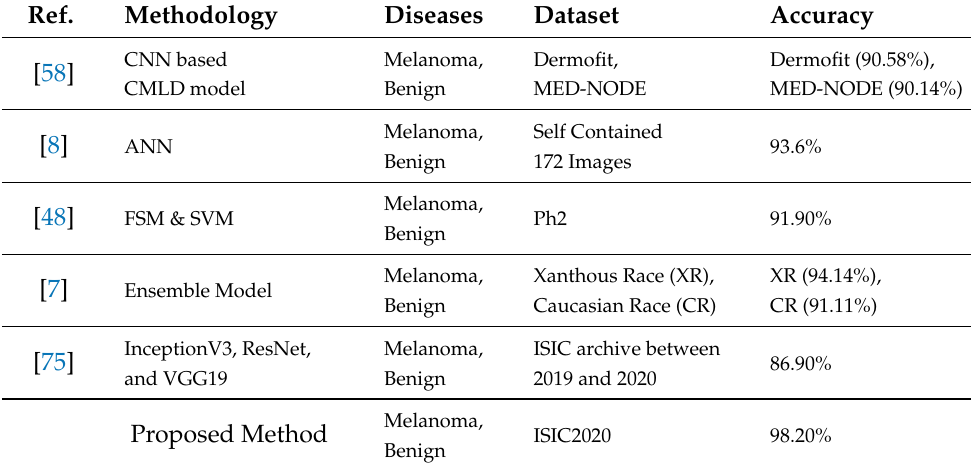
Table 6. Comparison with state-of-the-art models.